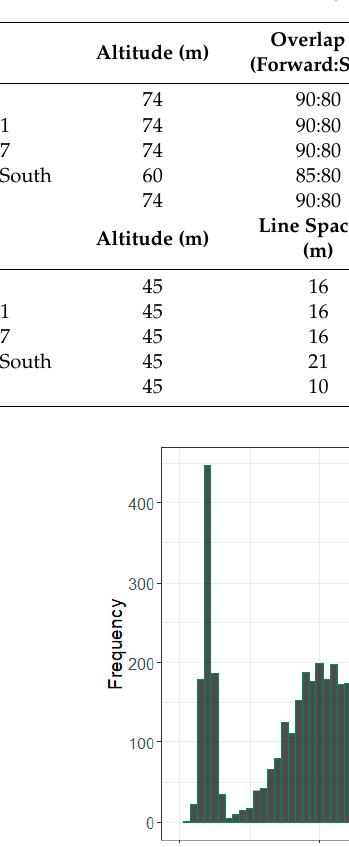
Table 2. Unmanned aerial vehicle (UAV) flight parameters for data captures.